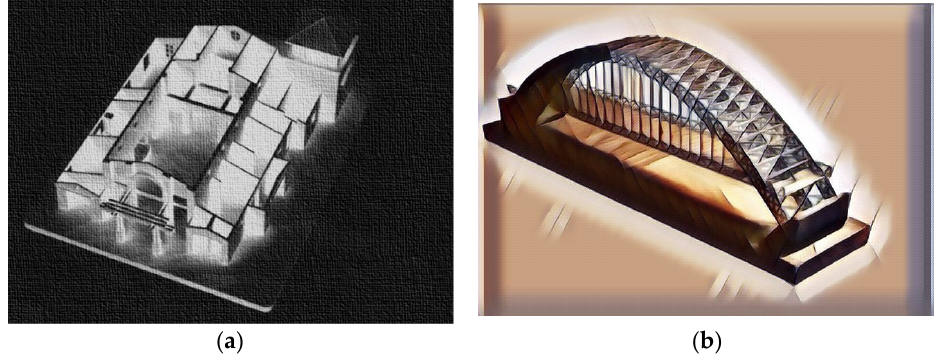
Figure 1. Mock-ups of ( a ) a public building; ( b ) a bridge created by 3D printing. Images created by A. Skoratko (inspired by